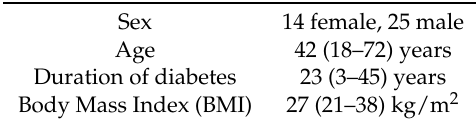
Table 1. Participant demographics, mean